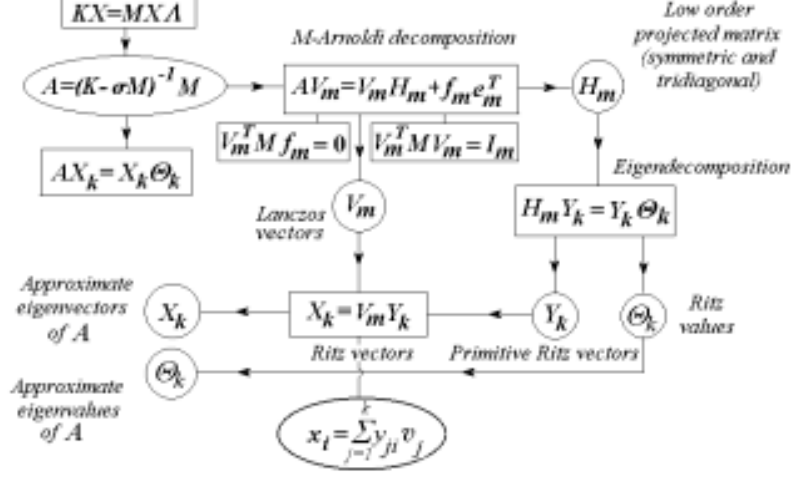
Fig. 2. Schematic of the M -Arnoldi